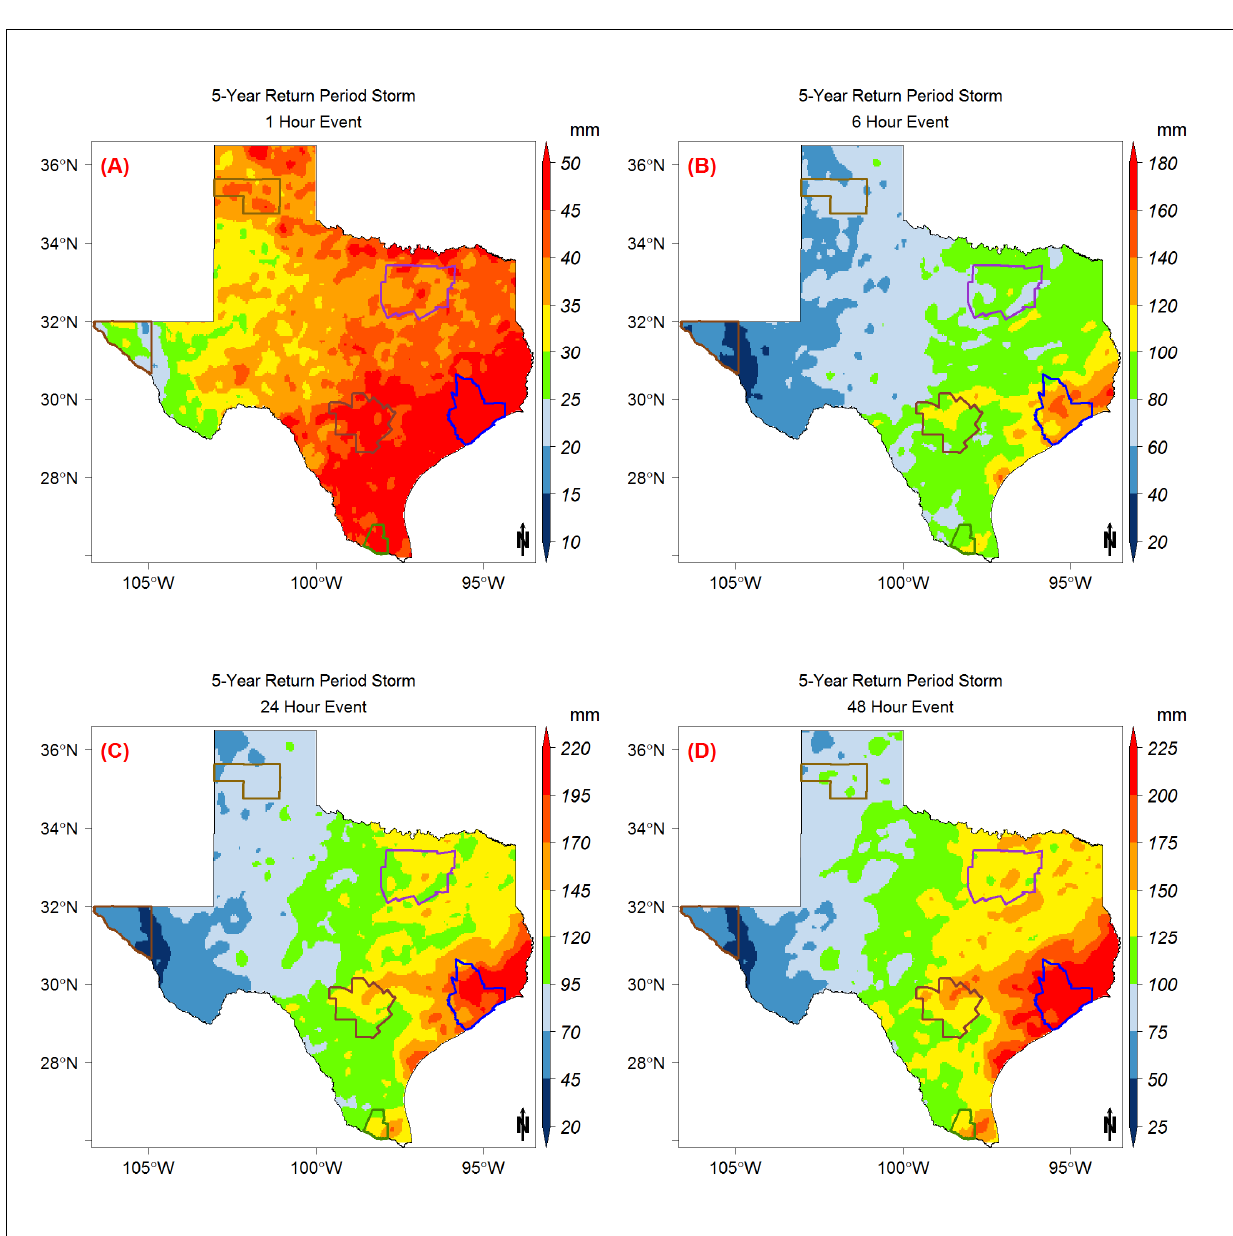
Figure A5. The 5-year return period storm event map modeled using the Gumbel model distribution for the ( A ) 1-h, ( B ) 6-h, ( C ) 24-h, and ( D ) 48-h storm durations.